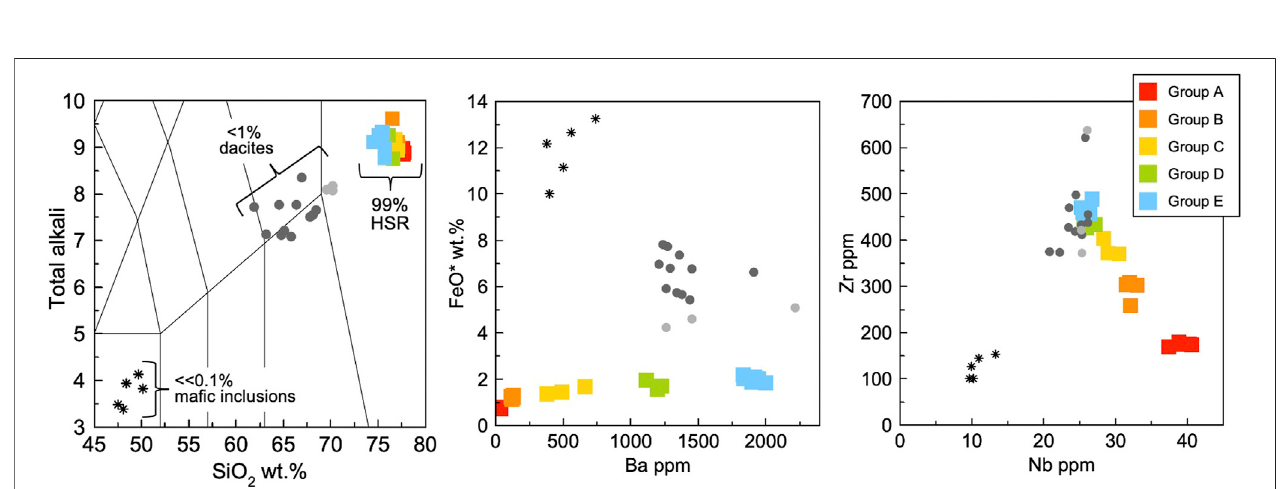
FIGURE 2 | Original Rattlesnake Tuff (RST) high-silica rhyolite (HSR), dacite pumices (that are variably banded), and ma fi c inclusions from Streck and Grunder (1997, 1999). The RST is comprised of 99% HSR, < 1% variably dacite pumices, and << 0.1% ma fi c, basaltic and basaltic-andesitic inclusions found within the dacites.